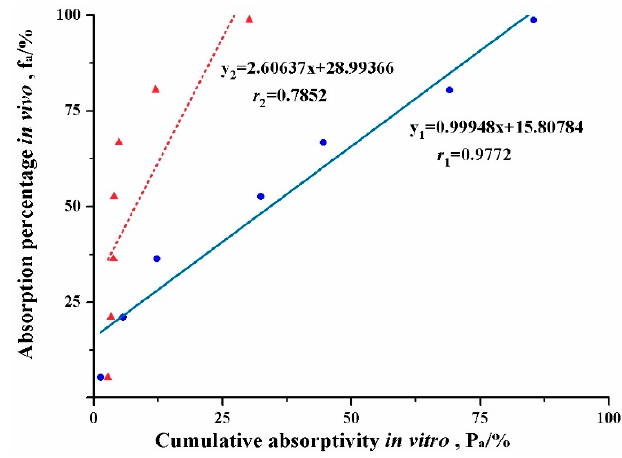
Figure 6. Plots of the in vivo-in vitro correlation of absorption curve for the lipid-based formulation of indomethacin obtained from the conventional everted gut sac model ( ▲ ) and the new ex vivo lipolysis-absorption model ( ● ), respectively.